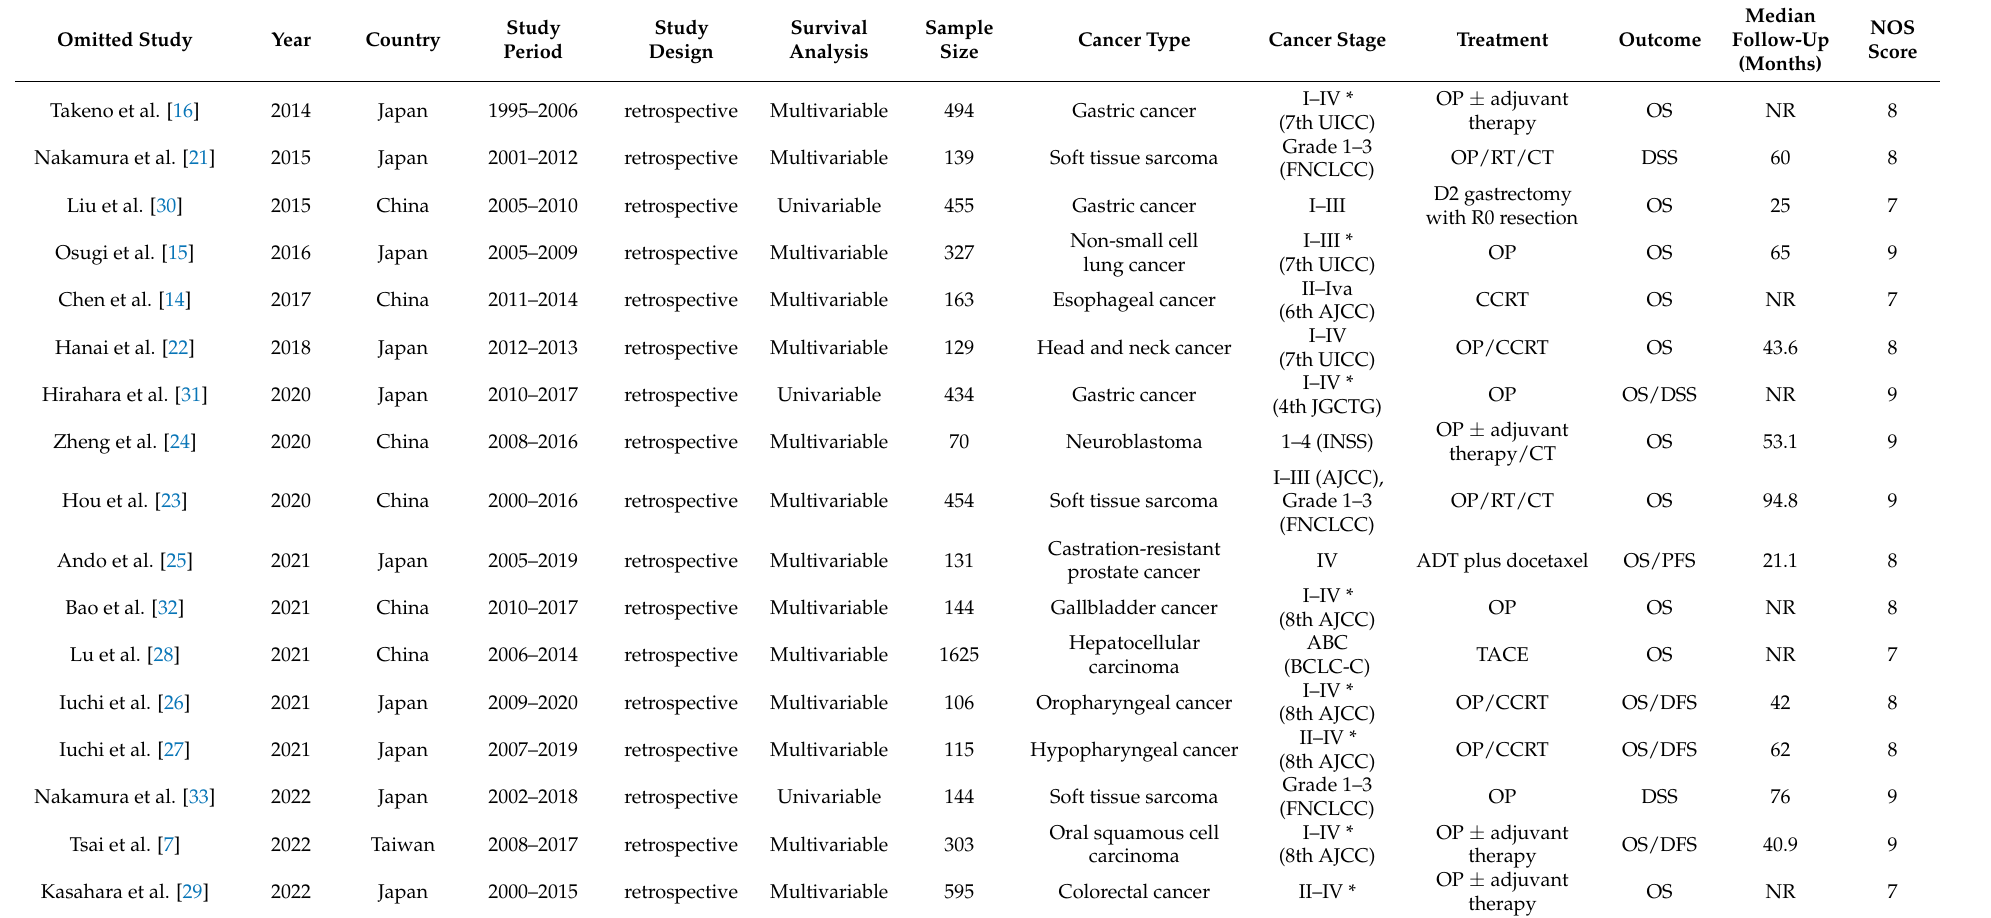
Table 1. The characteristics of included